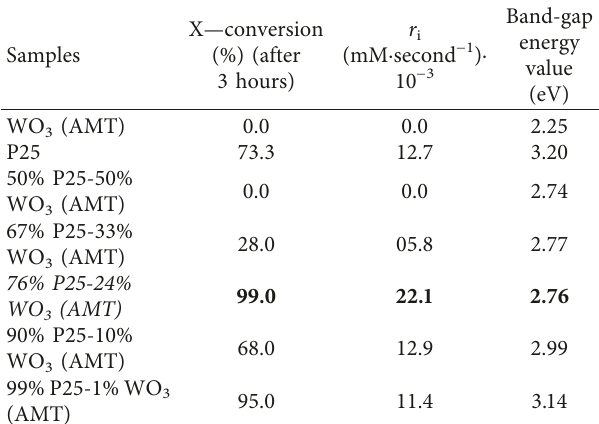
Figure 5: Photodegradation of 3 mM oxalic acid using under UV light irradiation in the presence of 50-50, 67-33, 76-24, 90-10, and 99-1 wt.% TiO 2 /WO 3 composites. Table 1: Summary of the photocatalytic properties for the various composite system and reference